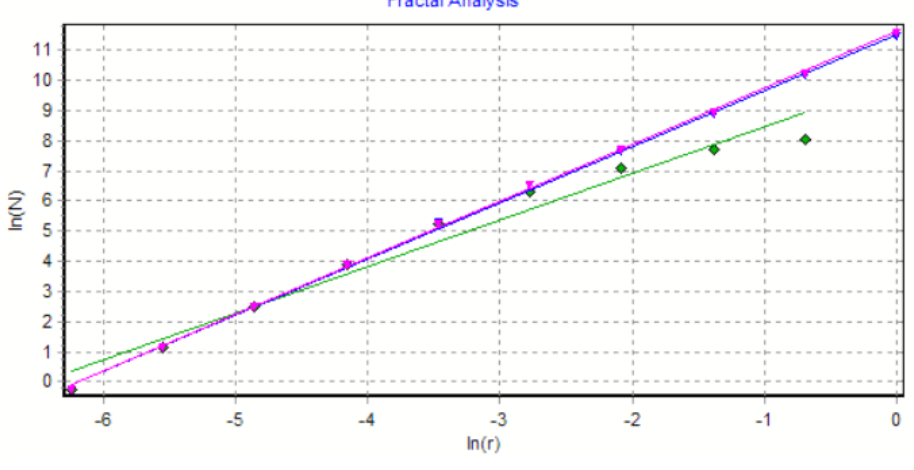
Figure 17. Graphic of fractal dimension for selected U 4 image area. Figure 18 represents the three-dimensional graph of the voxel representation for the image U 4 from the modified area.